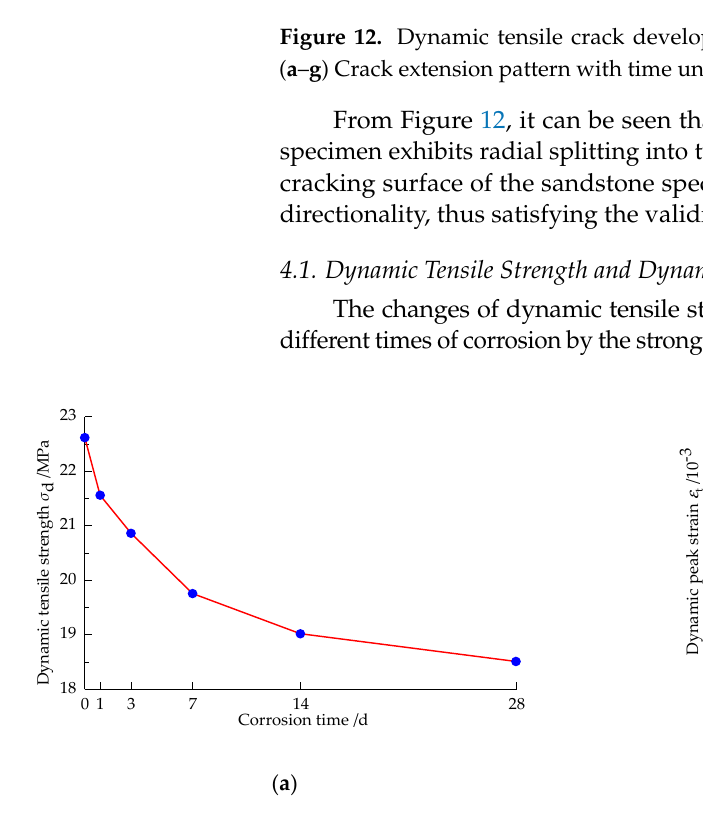
Figure 12. Dynamic tensile crack development process in sandstone under high-speed camera. ( a –